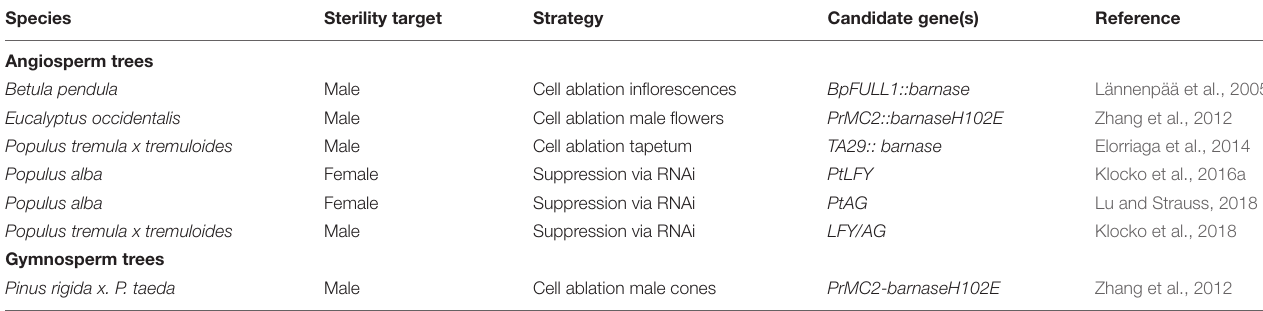
TABLE 1 | Examples of Engineered Sterility in Forest Trees.